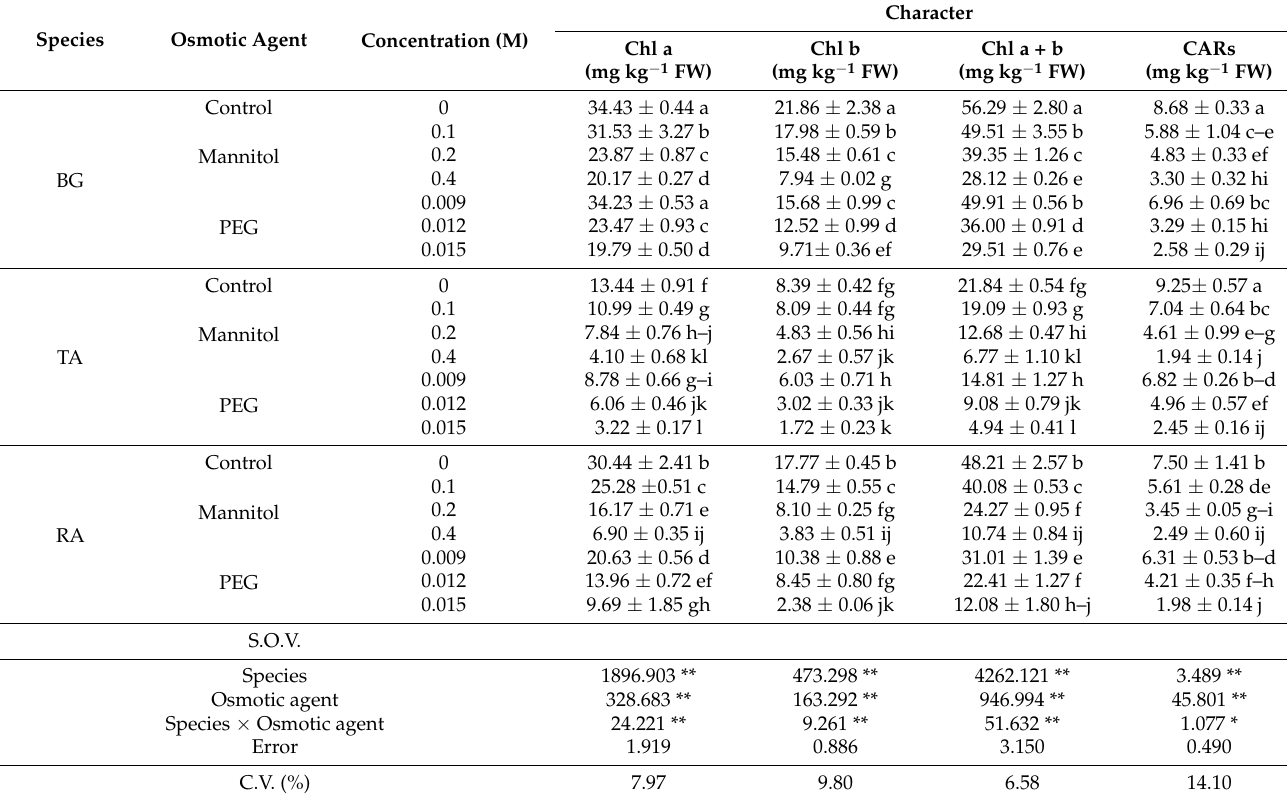
Table 2. Effect of osmotic stress induced by mannitol and PEG on photosynthesis pigments of Cucurbita sp. under in vitro culture